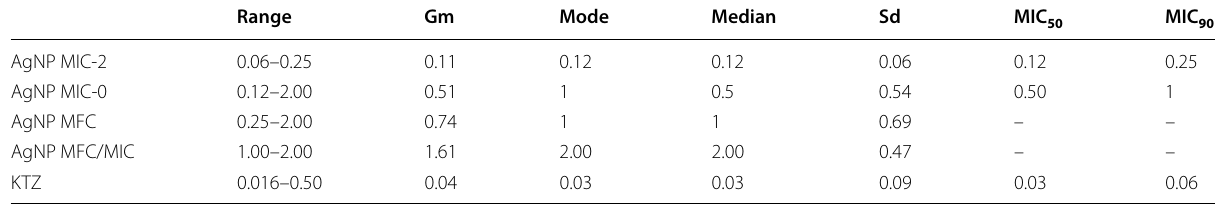
Table 1 MFC, MIC-2 and MIC-0 ranges, geometric mean (Gm), mode, median, standard deviation (Sd) and MIC and MIC obtained for 41 M. furfur isolates 90